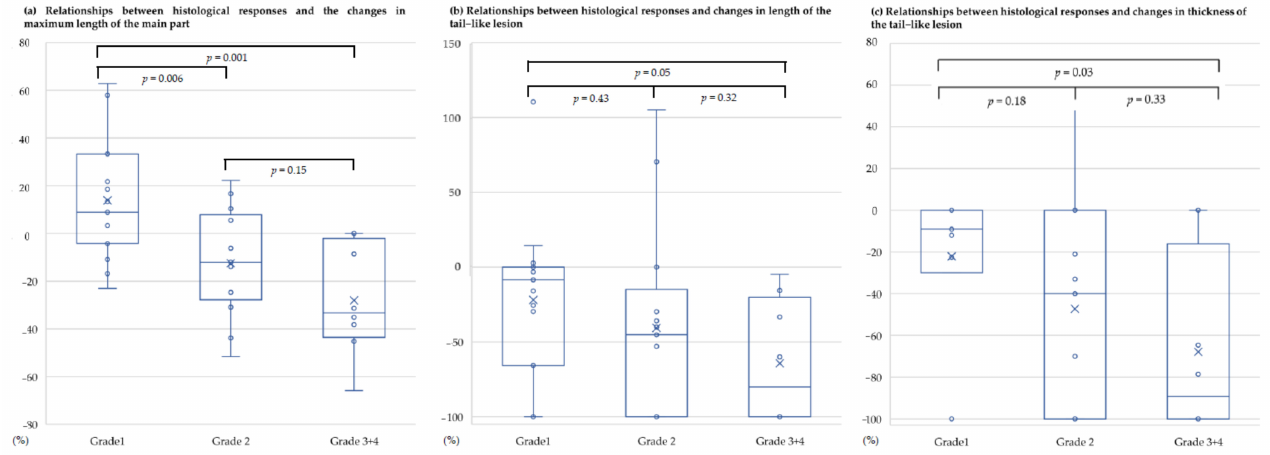
Figure 3. Box-and-whisker plots of the relationship between the histopathological evaluations and the shrinkage of tumors. ( a ) Relationships between the histopathological response and changes in the maximum length of the main part; ( b ) relationships between the histopathological response and changes in the length of the tail-like lesion; ( c ) relationships between the histopathological response and changes in the thickness of the tail-like